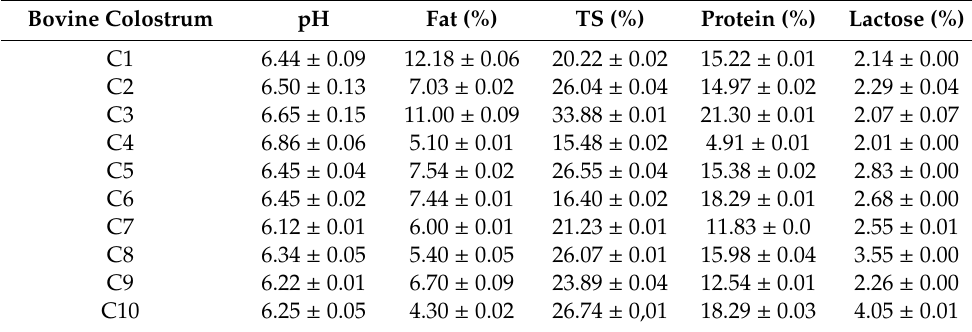
Table 2. Chemical composition of bovine colostrum samples (C1–C10).